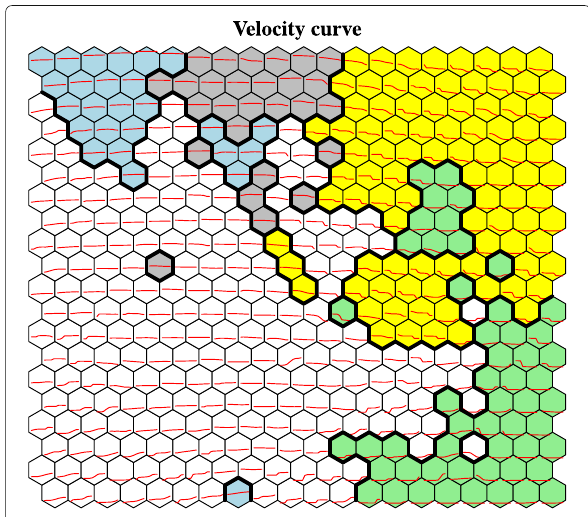
Fig.8 Brake Pedal Positionmap. 10-second brake pedalpositioncurve for each node represented as a line plot within the respective node